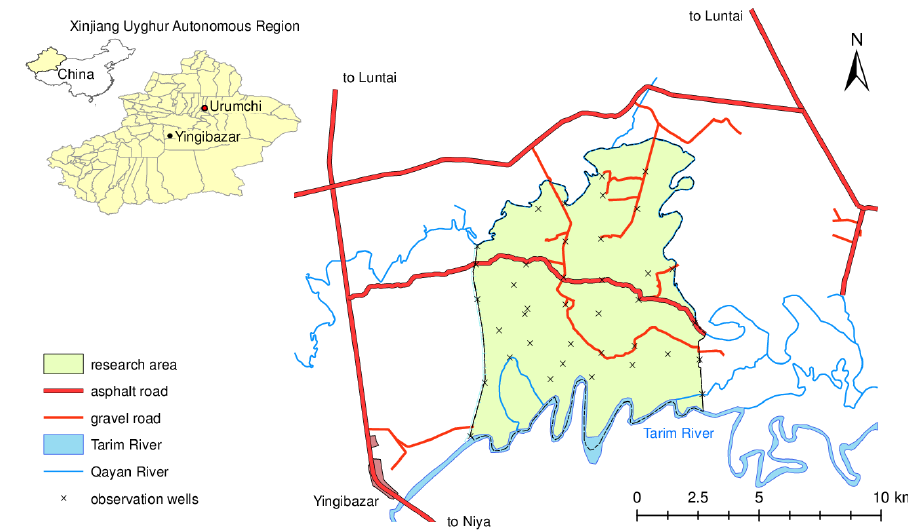
Figure 1. Location of the research site at Yingibazar in the middle reaches of the Tarim